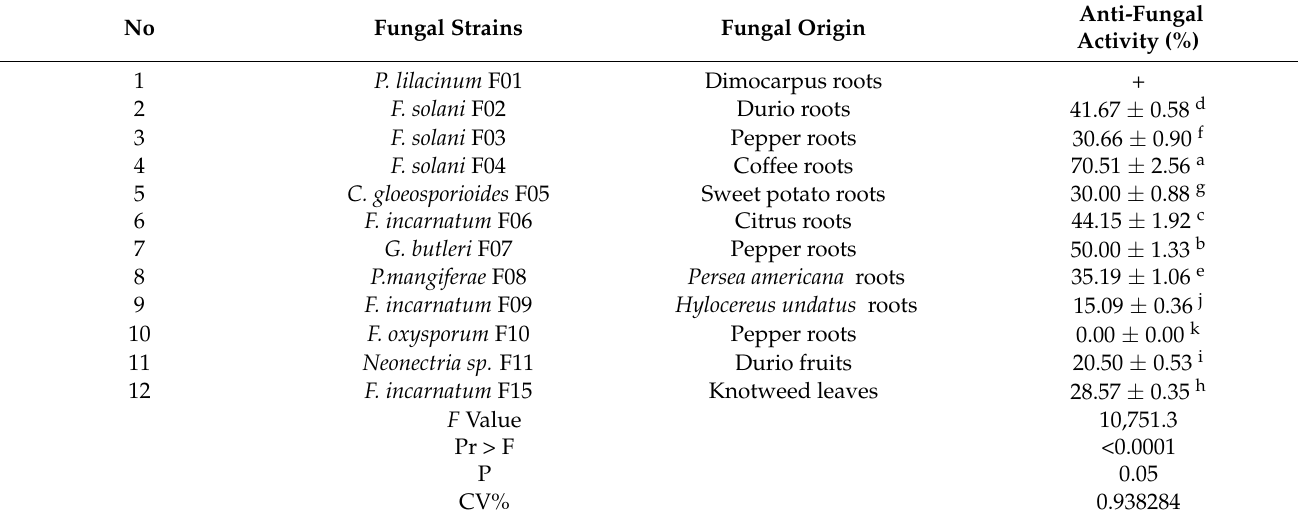
Table 6. Assessment of in vitro antifungal activity test of Pseudomonas aeruginosa TUN03 against various plant-pathogen fungal